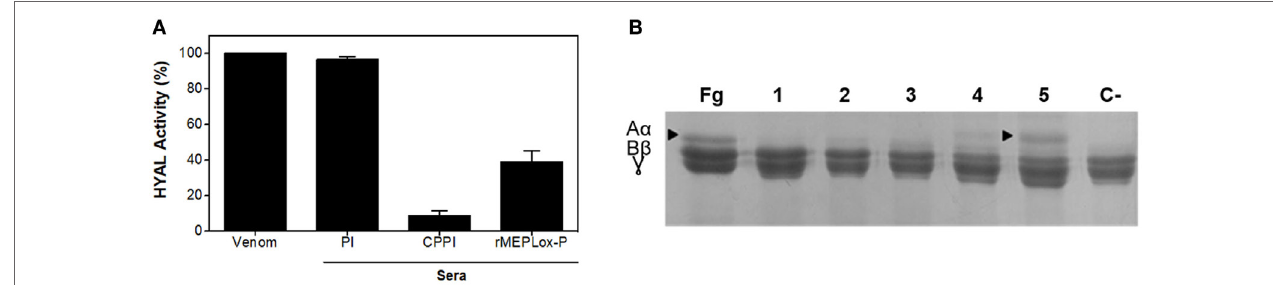
FigUre 8 | Neutralization of Loxosceles intermedia enzymatic activities by anti-rMEPLox antibodies. (a) Neutralization of hyaluronidase (HYAL) activity, measured in turbidimetric assay. L. intermedia venom (6.6 µg) was considered as 100% active. The same amount of venom was pre-incubated with either pre-immune sera (PI), commercial antivenom produced at CPPI or anti-rMEPLox sera (2 µL). (B) Neutralization of fibrinogenolytic activity by different amounts of rMEPLox antibodies. In the first lane, fibrinogen (Fg) showing its three subunits α , β , and γ intact. Lane 1 shows the degradation of the alpha chain when Fg is treated with 3 µg of L. intermedia venom. In the following lines, the venom was pre-incubated with concentrations of 2 (2), 10 (3), 40 (4), and 100 µg (5) of anti-rCpLi2 IgG. A negative control (C − ) was made with venom pre-incubated with non-immune